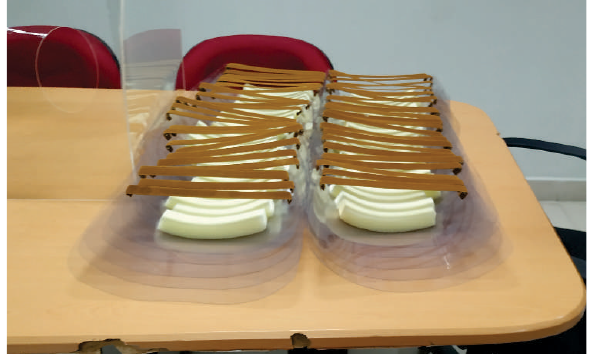
Figure 3: Locally made face visors